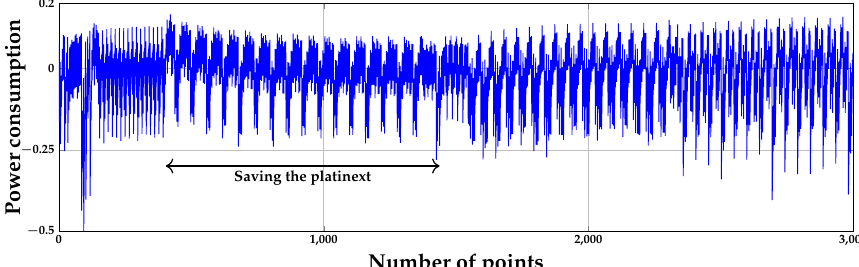
Figure 2. When the plaintext is stored in some local variables for the block cipher AES with no